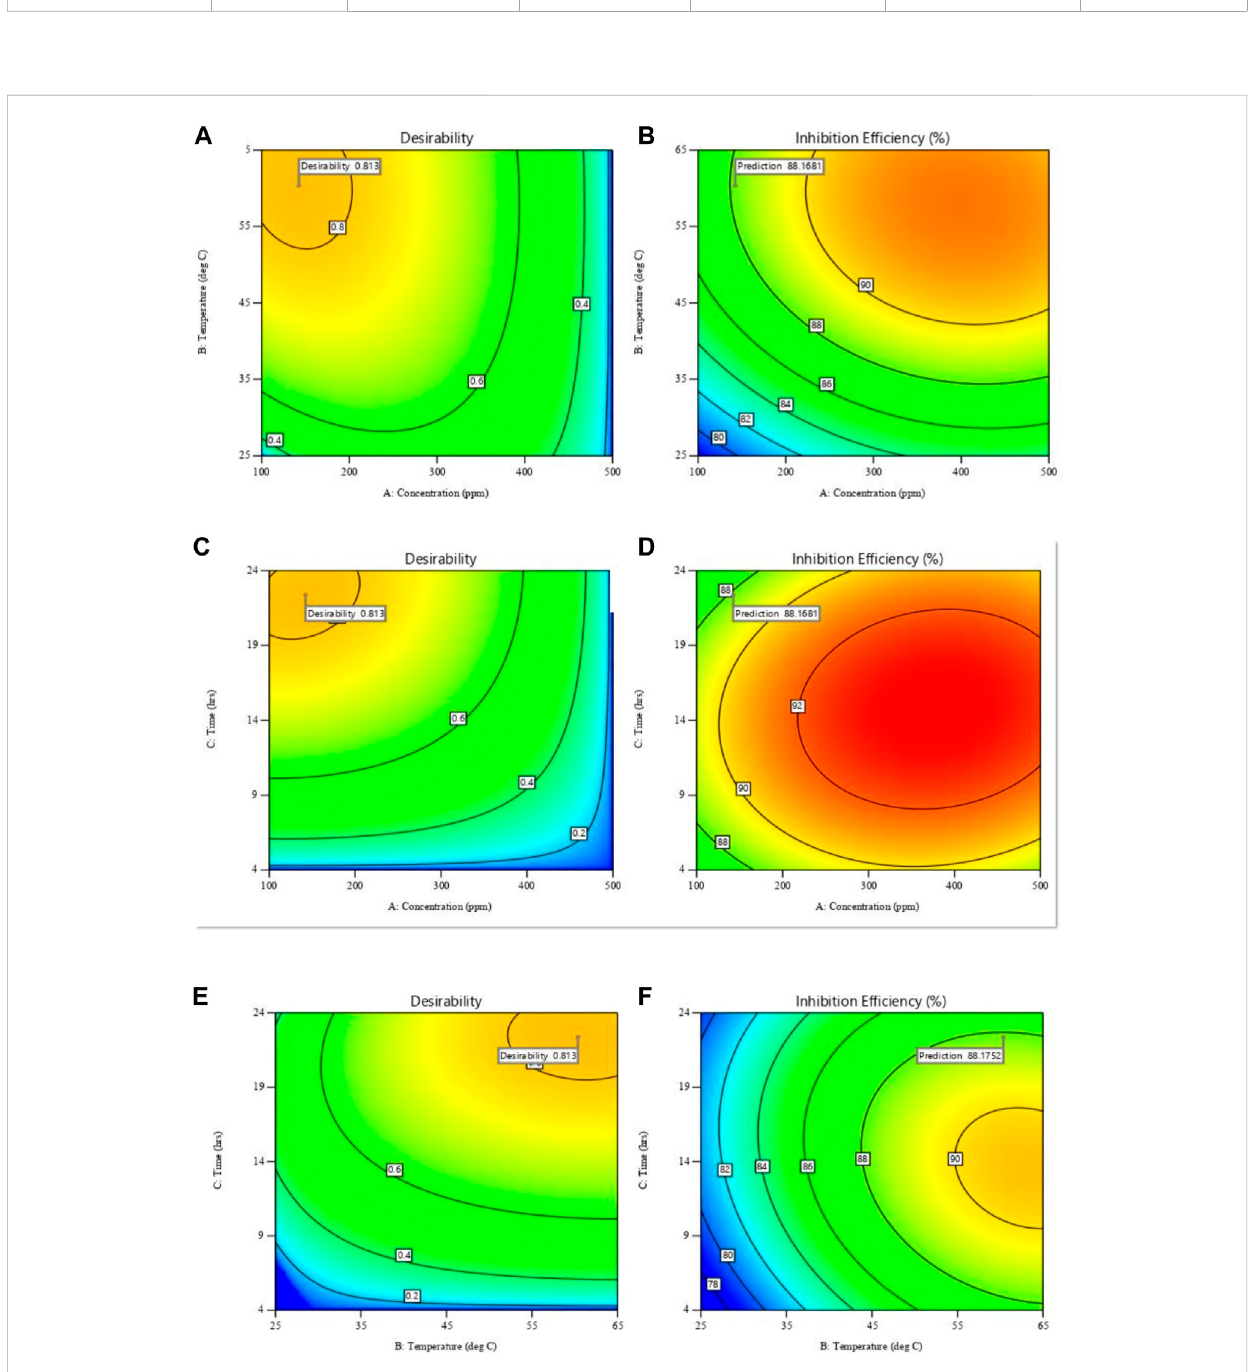
FIGURE 15 Contour plots for desirability (left) and inhibition ef fi ciency (right) against: (A,B) temperature and concentration; (C,D) time and concentration; (E,F) time and